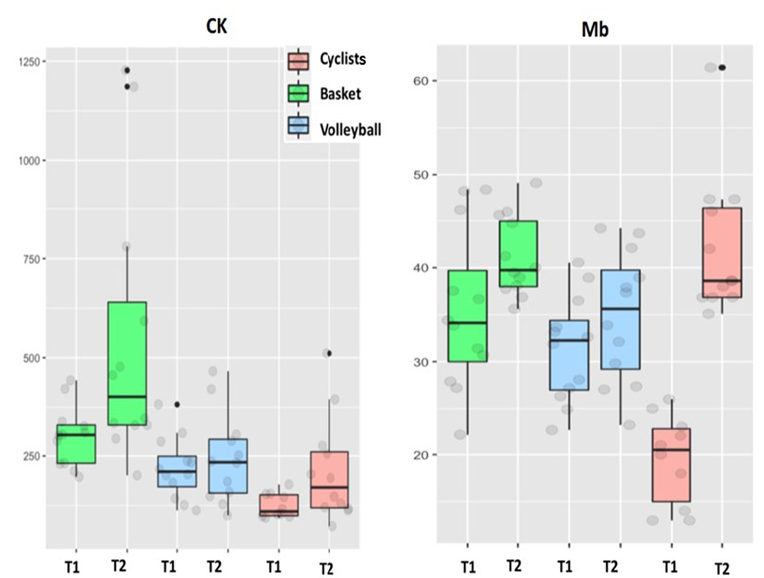
Figure 3. Creatine kinase (CK) (IU/L) and myoglobin (Mb) (ng/mL) plasma levels in cyclists, basketball and volleyball players at the end of T1 and T2.